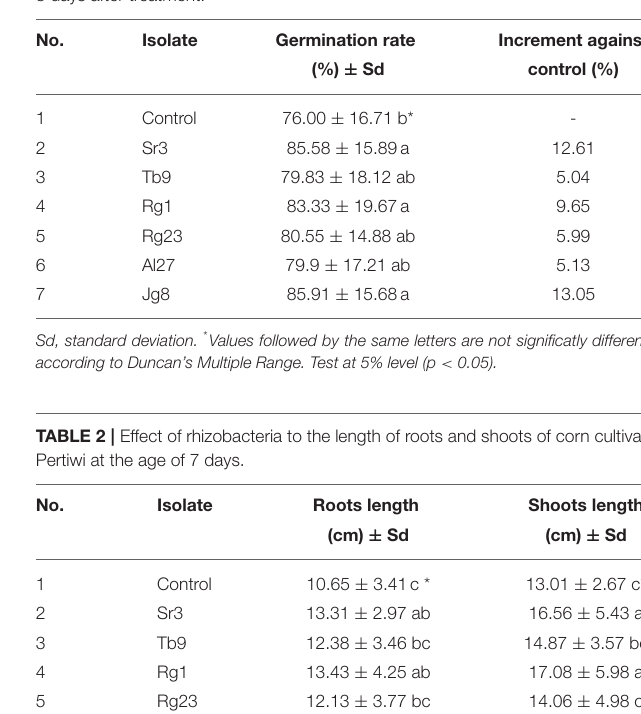
TABLE 1 | Effect of rhizobacteria to the germination rate of corn cultvar Pertiwi at 3 days after treatment.